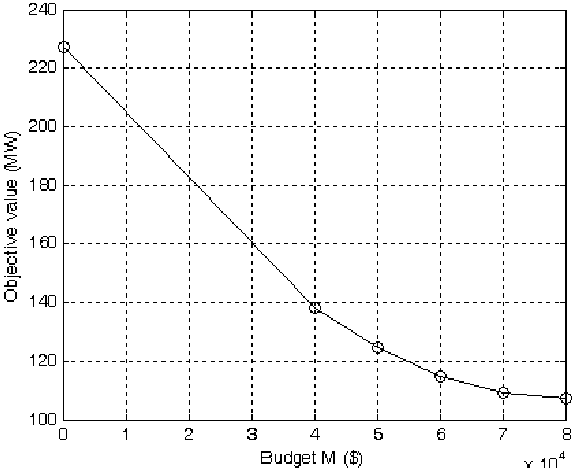
Figure 4. The objective values vs. budget on the IEEE 244-bus system for each of these investment examples.